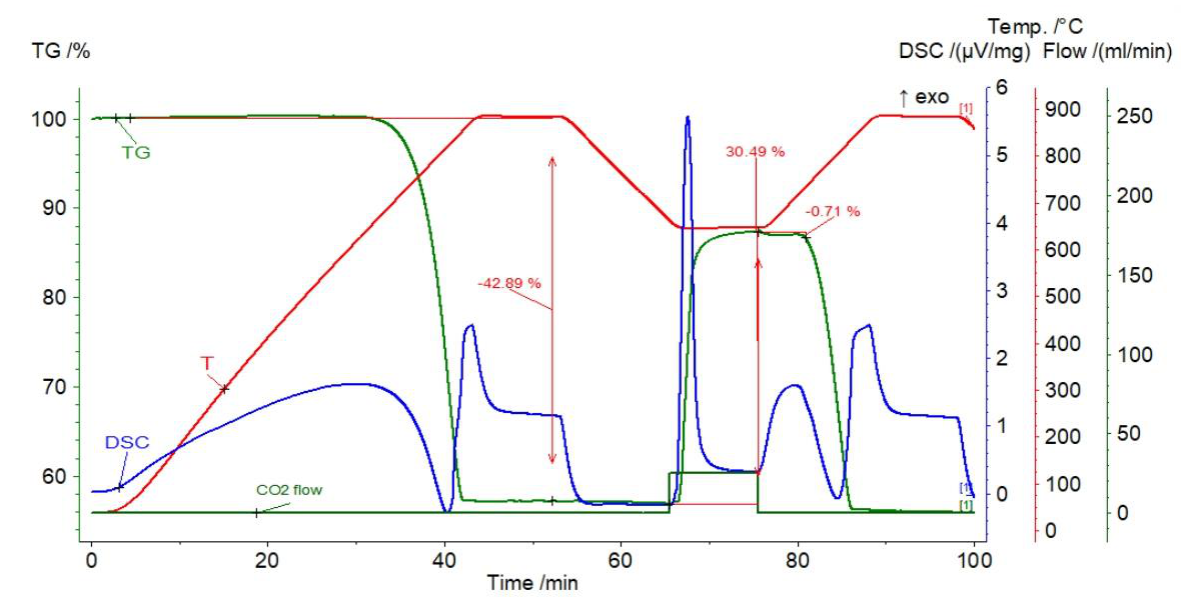
Figure 6. TGA and DSC curves for limestone from Saint Anne Mountain.